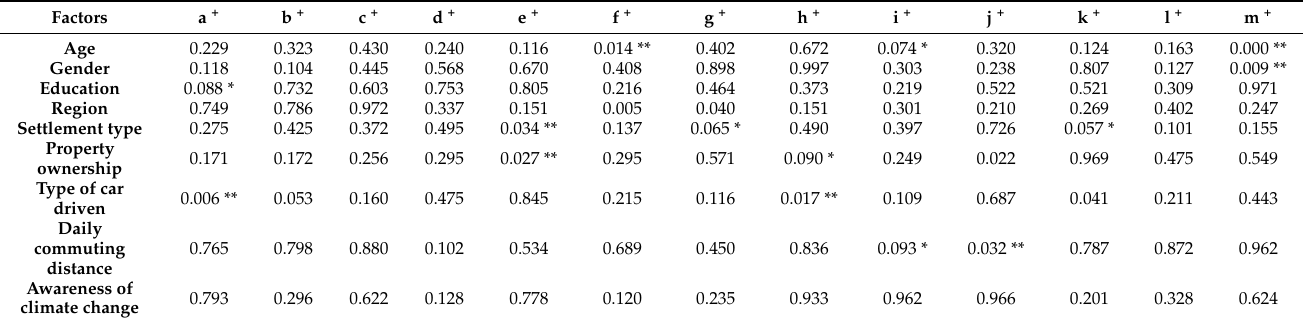
Table 5. Chi-square tests between demographic factors and factors that influence electric vehicle absorption.